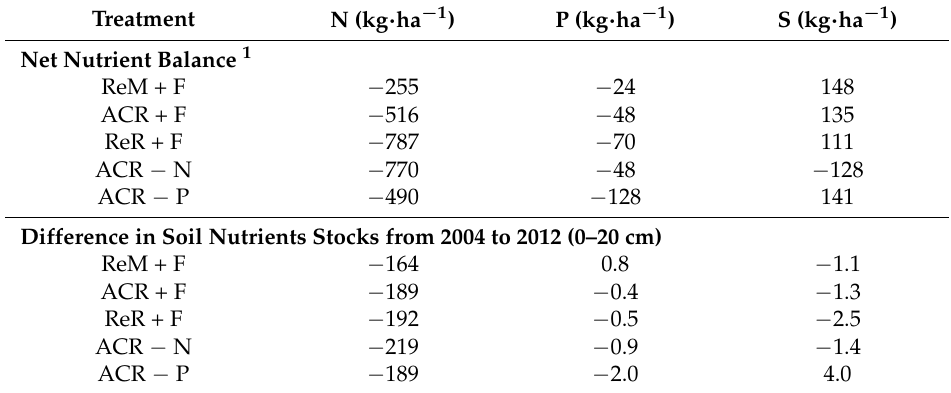
Table 4. Nutrient balance in two Eucalyptus grandis rotations under different timber harvest intensities and fertilizer